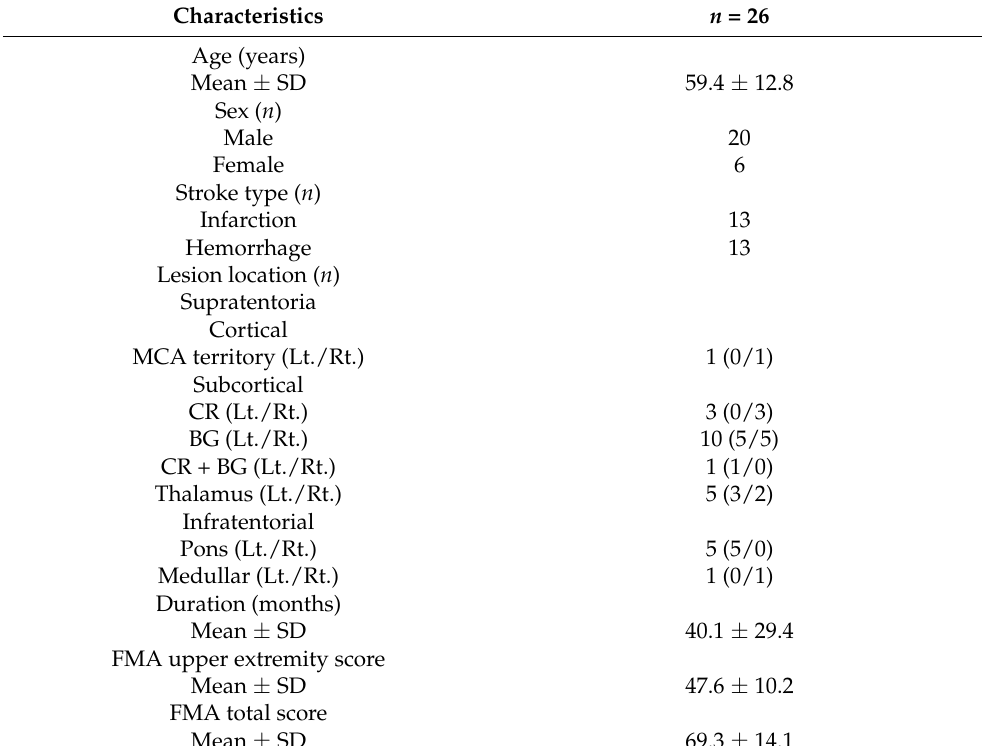
Table 1. The clinical characteristics of